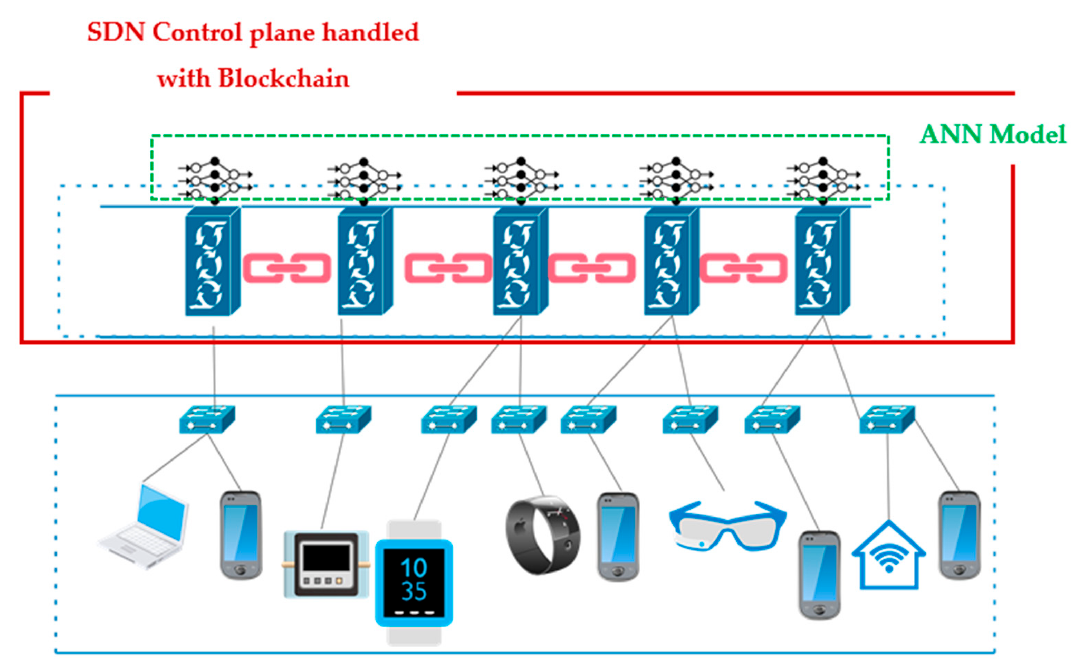
Figure 4. Proposed system